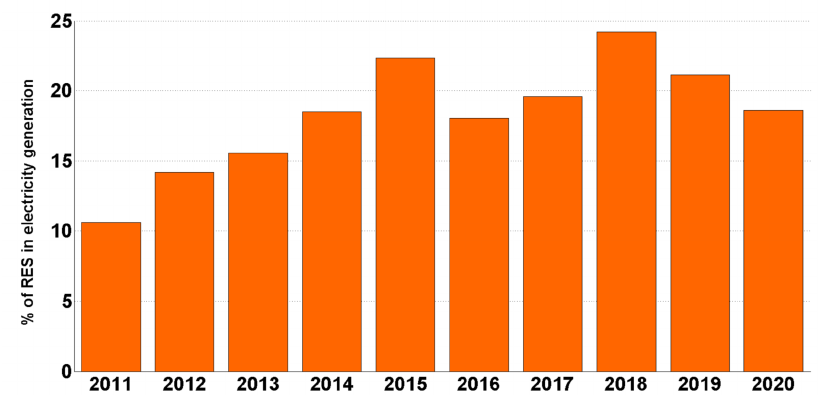
Figure 17. Annual share of RES in electricity generation in Belgium